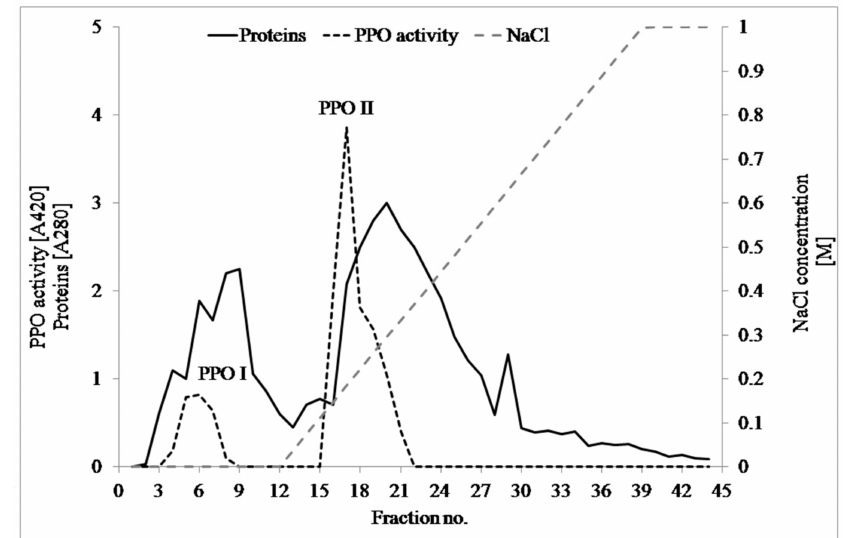
Figure 1. Anion exchange chromatographic elution profiles obtained after applying dissolved and desalted saline precipitate extract of lentil